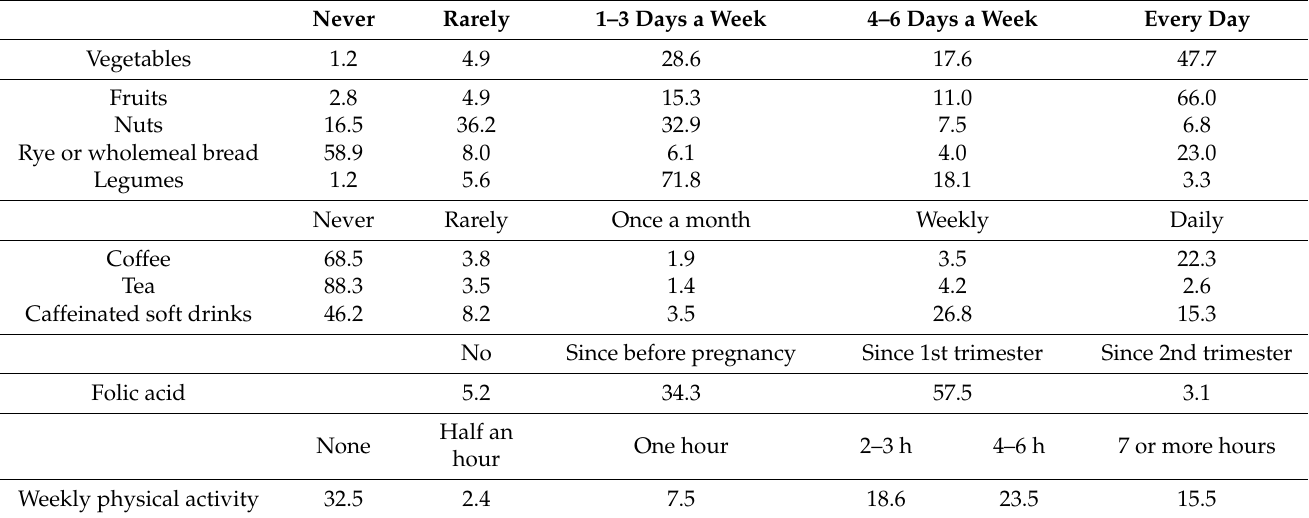
Figure 1. Frequency of alcohol and tobacco consumption during pregnancy. Table 2. Frequency of food and acid folic consumption, as well as physical activity during